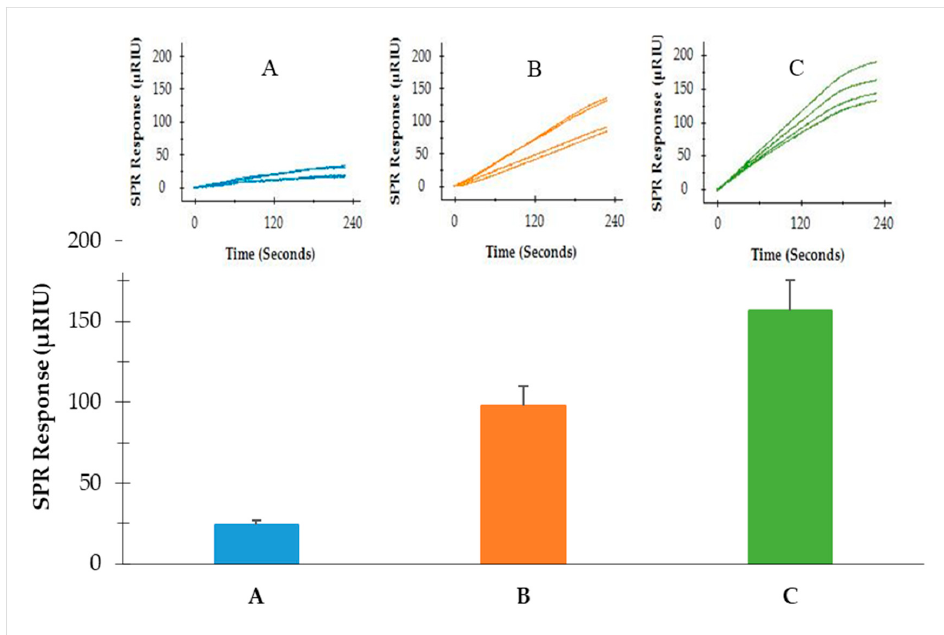
Figure 5. SPR responses of the romaine lettuce samples contaminated with different levels of S . Typhimurium ( A ) 5.5 log cfu/g, ( B ) 6.0 log cfu/g and ( C ) 6.5 log cfu/g, analyzed by the